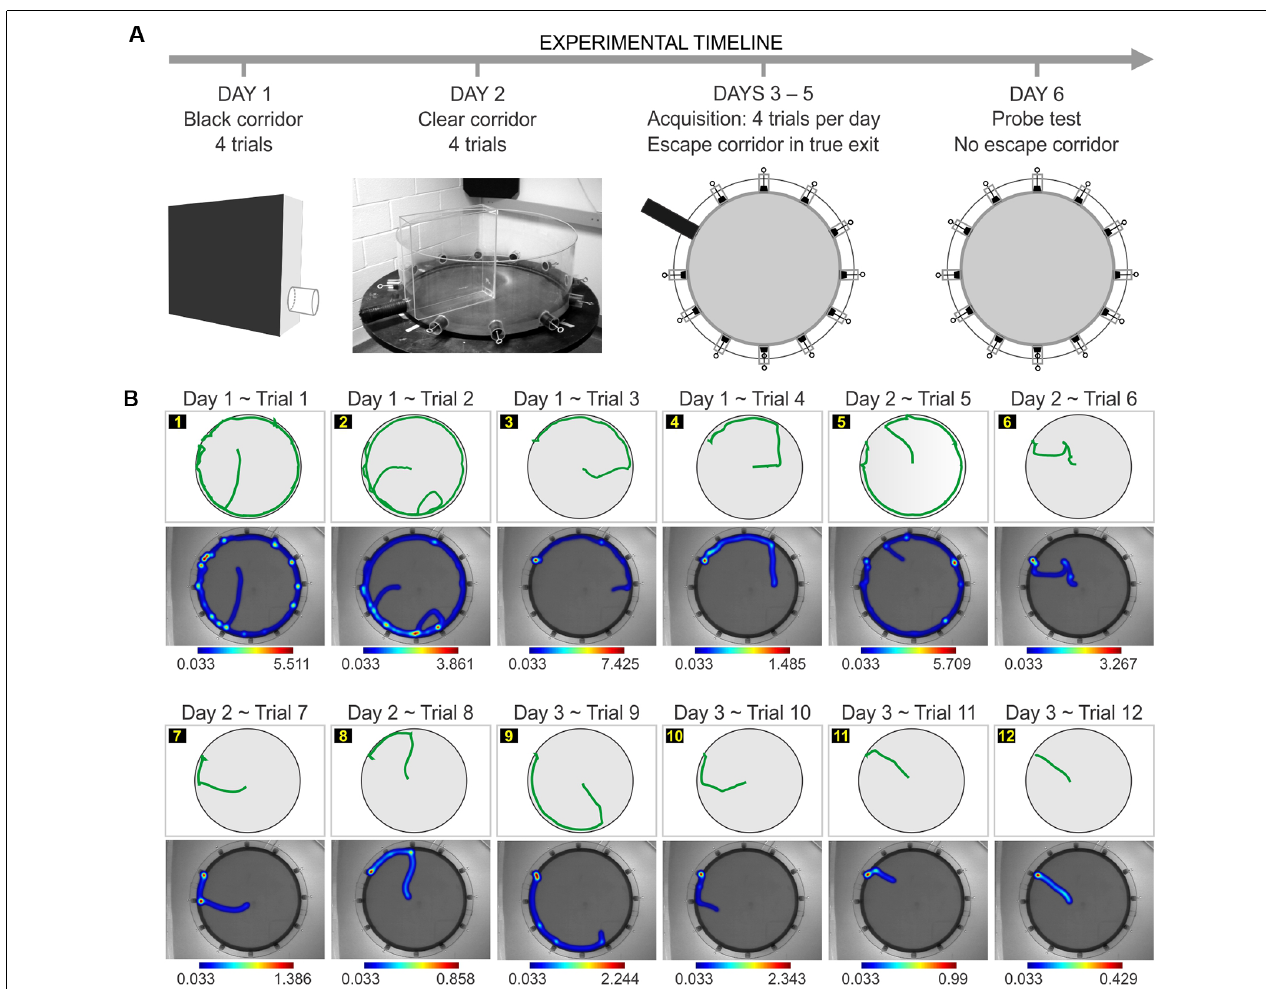
FIGURE 1 | Implementation of the paddling pool task (PPT) in the clockmaze. (A) Experimental timeline for the task with pre-training in a black corridor (day 1) and a clear corridor (day 2). This is followed by acquisition in the clockmaze, with a single open hole (true exit; days 3–5), and a probe test with the all the exits blocked (day 6). (B) Representative experiment showing the trial-by-trial performance of an individual C57 female in which the true exit is at hole 10. For each trial, the track plot is at the top, and the heatmap of occupancy is at the bottom with its corresponding color scale (values are expressed in seconds).